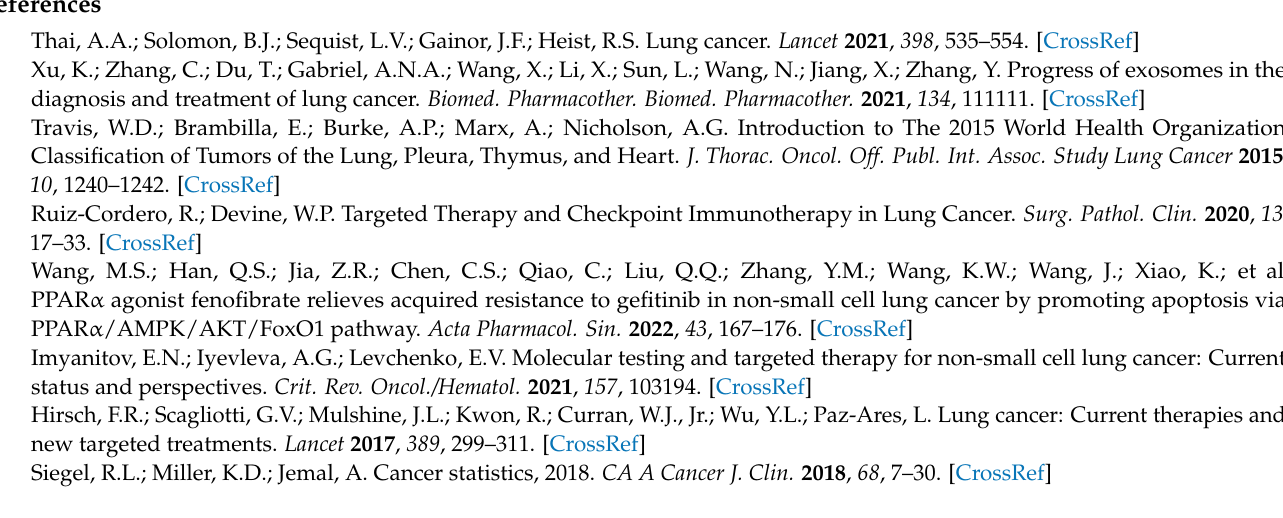
Figure S2: Original unedited bands for evaluating 6-SH treatment (20 µ M) affected the HSP60 in different Temp. by western blotting in Figure 4D; Figure S3: Original unedited bands for evaluating the expression levels of HSP60 after treating with MG132 by western blotting in Figure 4G; Figure S4: Original unedited bands for evaluating 6-SH treatment (0–80 µ M) affected the relevant signaling molecules in A549 cells by western blotting in Figure